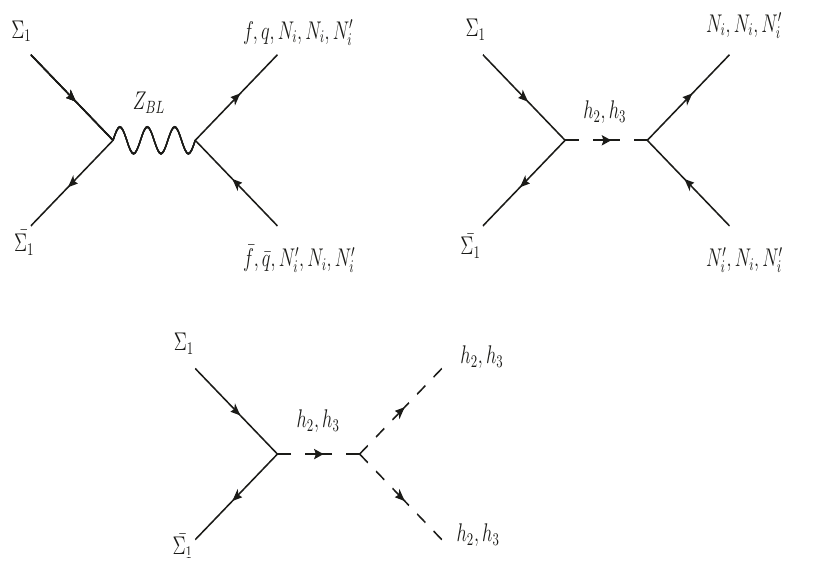
Figure 6 . Feynman diagrams for the annihilation of dark